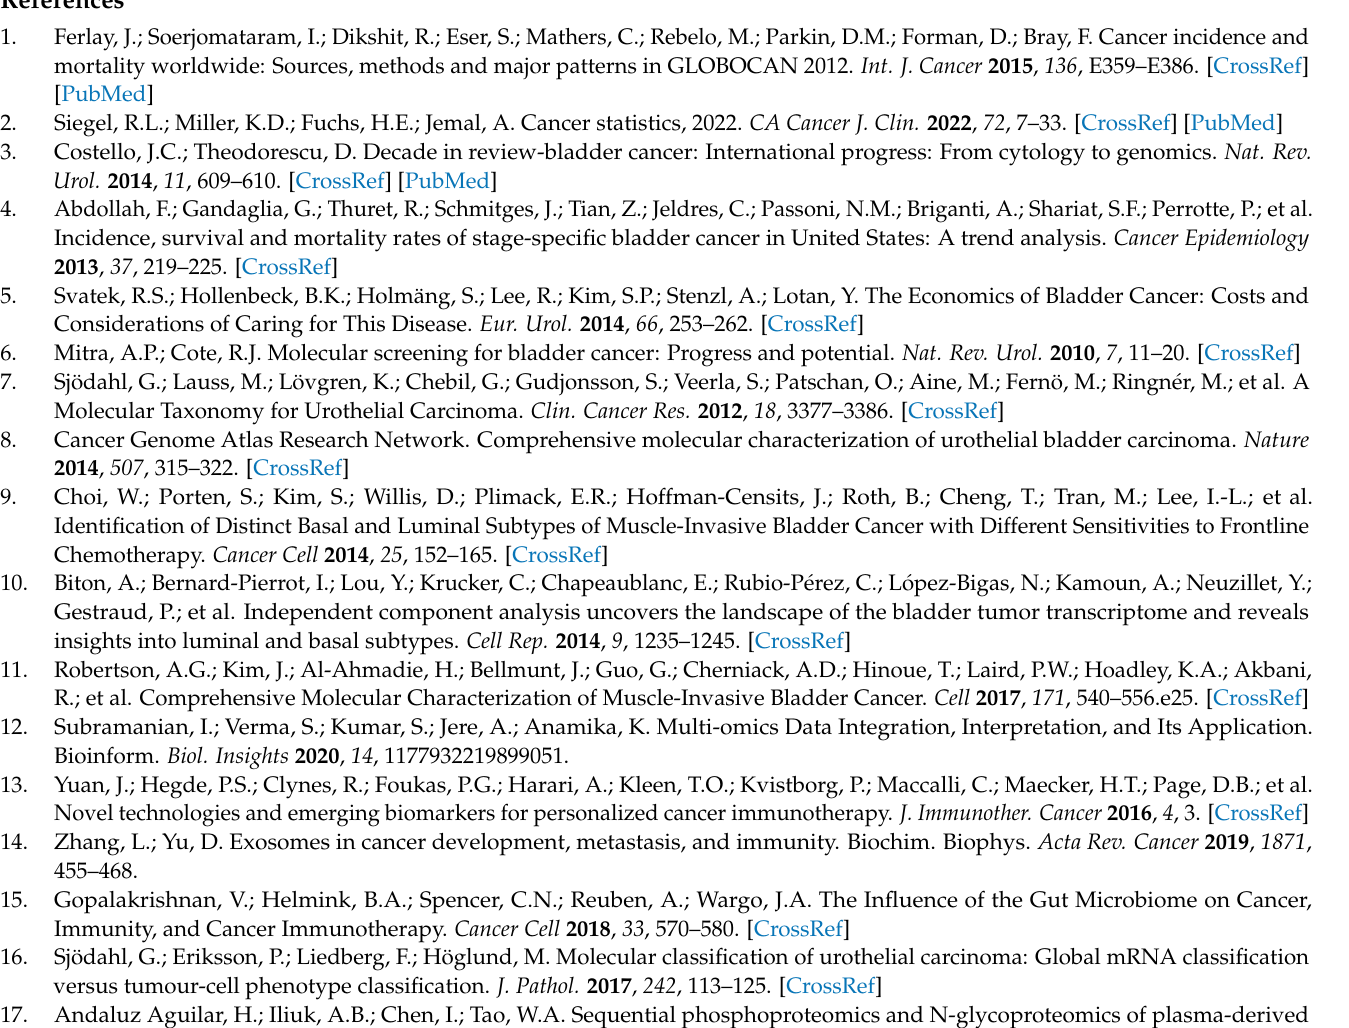
protein 2; PBS, Phosphate-buffered saline; PHPT1, phosphohistidine phosphatase 1; PCoA, Principal coordinates; PTS, 6-pyruvoyltetrahydropterin synthase; Rpm, Revolutions Per Minute; SPTA1, Spec- trin alpha chain erythrocytic 1; TEAB, Triethylammonium bicarbonate; TFA, Trifluoroacetic acid; TMOD1, ropomodulin-1; TNM, Tumour, Node and Metastasis; UPLC, Ultra performance liquid chromatography; UPLC, Ultra performance liquid